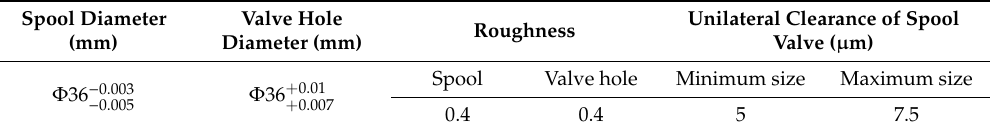
Table 5. Unilateral clearance range of a Φ 36 spool valve.